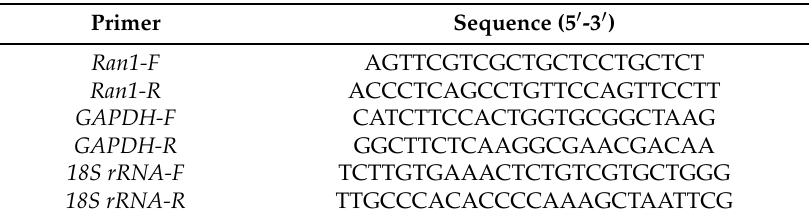
Table 3. Primers used in real-time quantitative